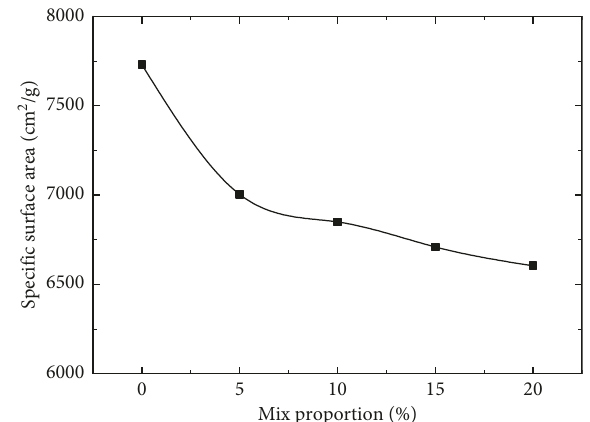
Figure 11: Effect of RHA-lime on the specific surface area of expansive soil.